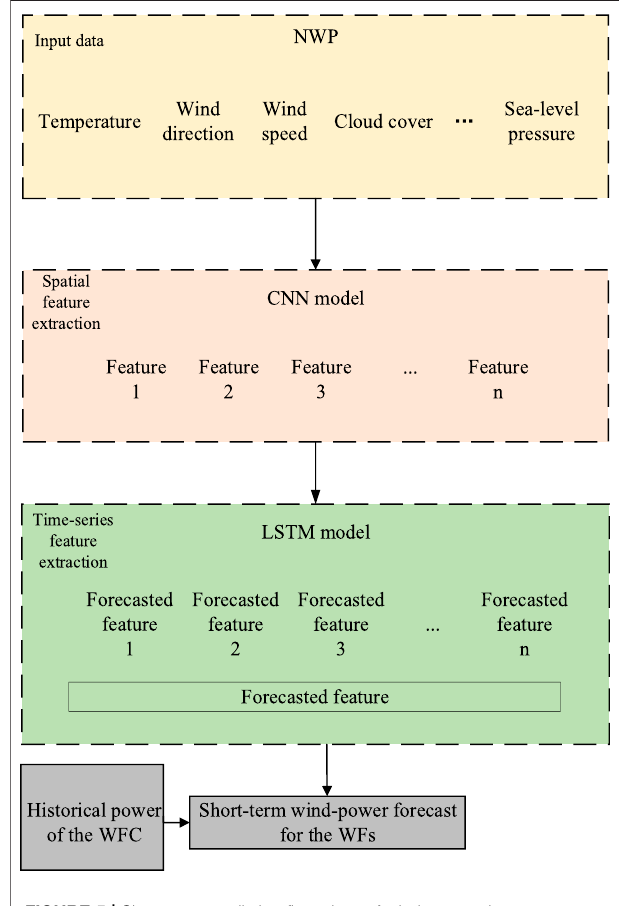
FIGURE 5 | Short term prediction fl ow chart of wind power cluster output based on CNN-LSTM model.